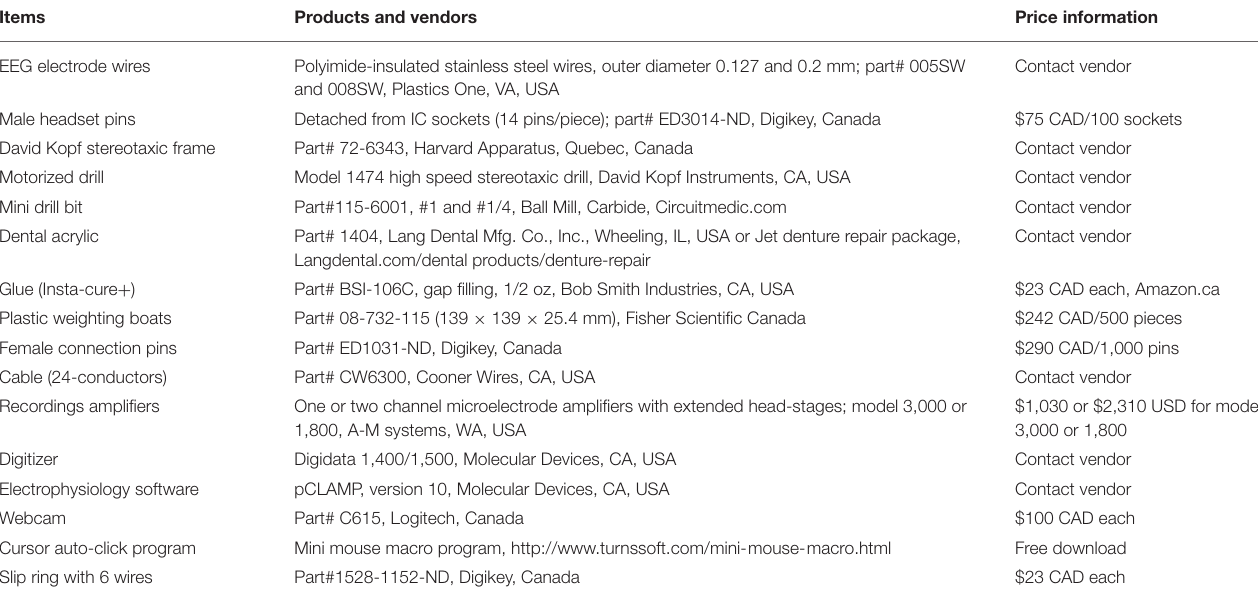
TABLE 1 | Main materials and equipment used in our